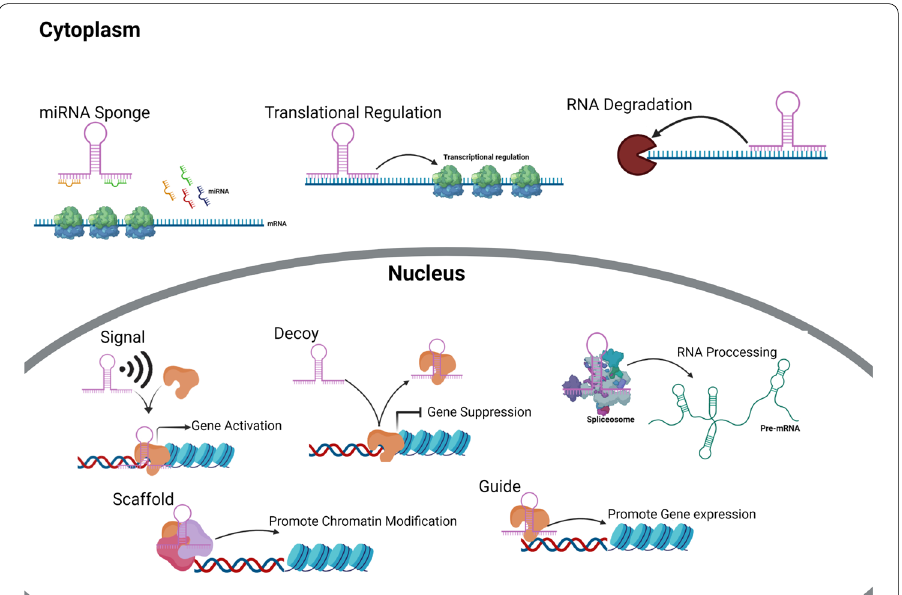
Fig. 1 The molecular mechanisms of lncRNA actions in pathophysiological